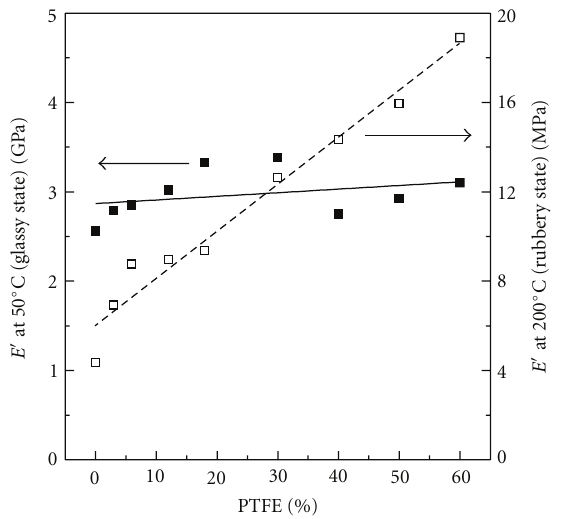
Figure 11: Trend of the storage modulus E (cid:3) in glassy (full symbols, GPa) and rubbery (open symbols, MPa)